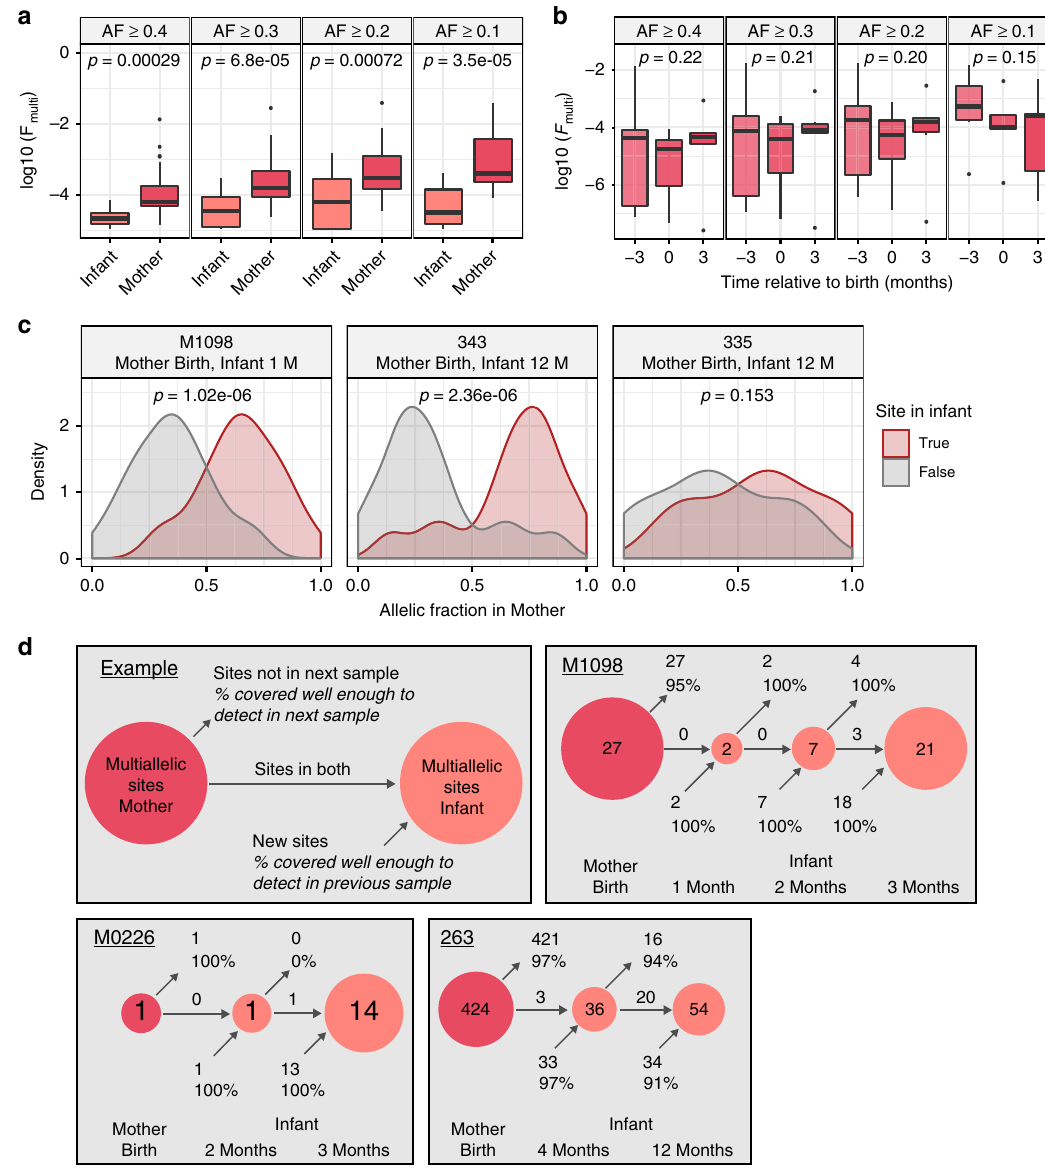
Fig. 2 P-crAssphage populations in mothers and infants differ in strain diversity. a The p-crAssphage population in mothers has more multiallelic sites than the p-crAssphage population in infants. F multi (fraction of the p-crAssphage genome with multiallelic sites detected at the given allelic fraction threshold) in all mother and infant samples with at least one multiallelic site detected. P-values were calculated with the two-sided Wilcoxon rank-sum test and are uncorrected for multiple hypothesis testing. b P-crAssphage populations in mothers do not change in the number of multiallelic sites over time. F multi for mother samples from Yassour et al. 16 . P -values were calculated with a linear mixed model to account for repeated sampling of the same individual. c Allelic fraction of multiallelic sites in the p-crAssphage genome from mothers that are fi xed in her infant. The distribution is separated by alleles that are present in the infant ’ s p-crAssphage or not. P -values were calculated with the two-sided Wilcoxon rank-sum test. d Schematic depicting multiallelic sites in mother and infant samples over time. In the three cases where p-crAssphage was detected in the mother and multiple samples from the same infant, infants develop more multiallelic sites over time. Additional examples of multiallelic sites in mothers and infants are provided in Supplementary Fig. 10. In all boxplots, boxes extend to the fi rst and third quartile, whiskers extend to the upper and lower value within 1.5* interquartile range (IQR) from the box. Outliers are shown as